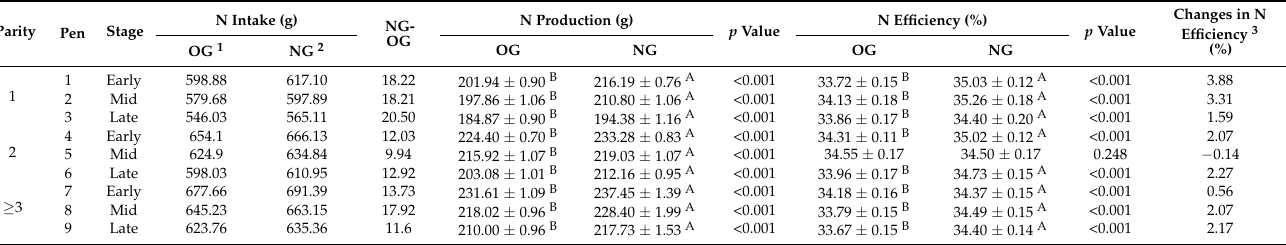
Table 6. Effects of different grouping strategies on dietary N utilization.